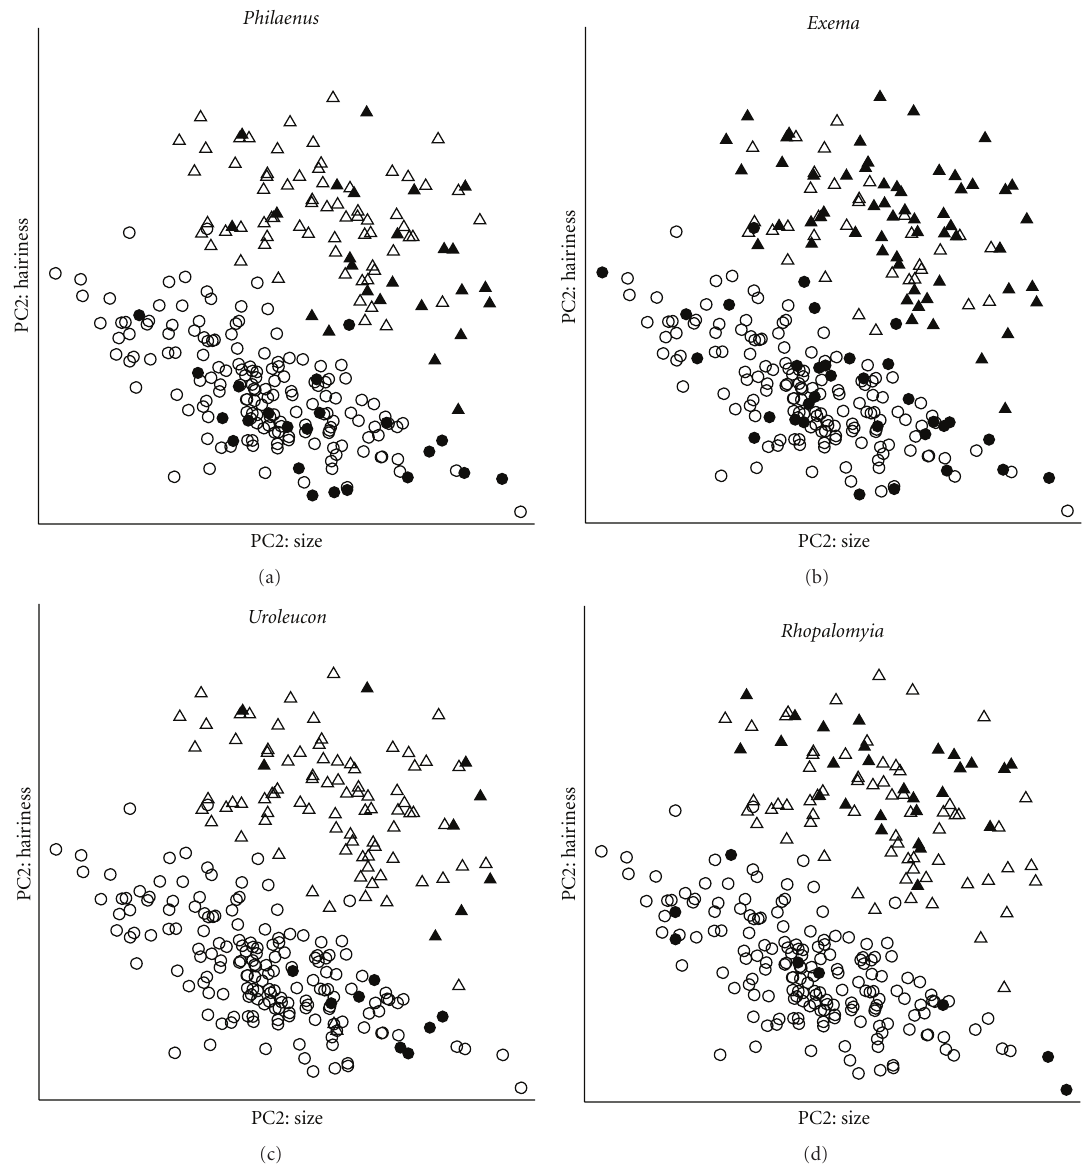
Figure 3: Attacked trait spaces for four goldenrod herbivores on S. altissima (triangles) and S. gigantea (circles). Filled symbols denote attacked plants, and open symbols unattacked ones. Axis labels are shorthand for the first two principal components from a 7-variable morphological dataset; full factor loadings are provided in Table